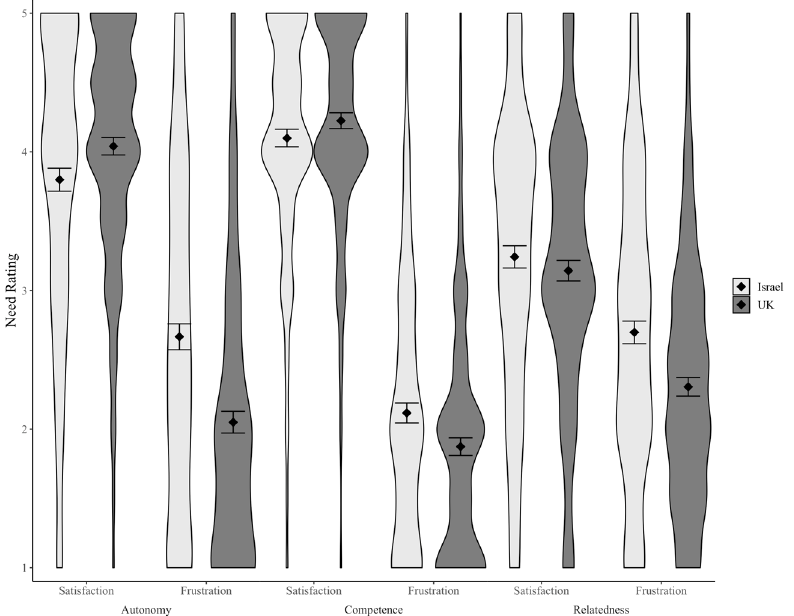
Figure 1. Violin plot displaying the distributions of participants’ need satisfaction and frustration ratings in Israel and the UK. Diamonds represent the cell means and error bars represent the 95% confidence intervals around those means.